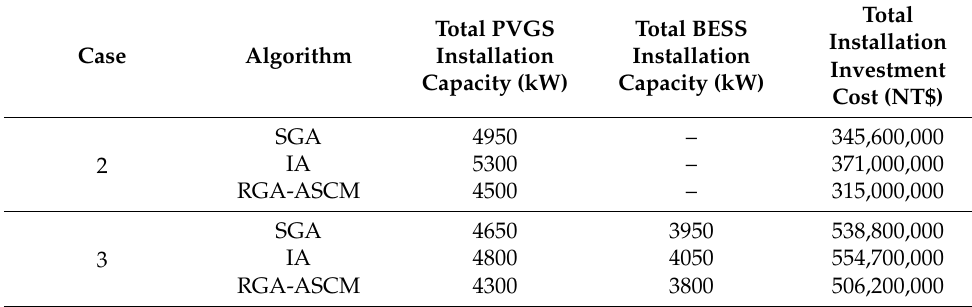
Table 3. Comparison of the total installation cost in Case 2 and Case